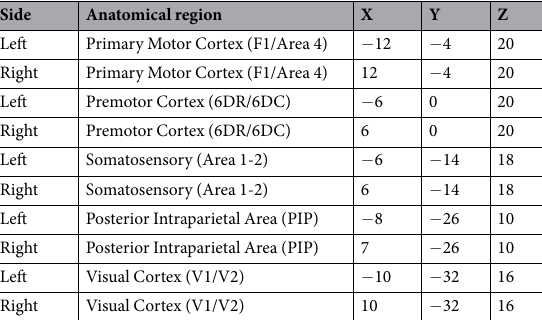
Finally, the third was also an increase in FC between the right visual and the left primary motor cortex (PMC). This FC had a significant negative correlation with the NHPSS scale (r = − 0.78, p = 0.004) (Fig. 3, third row). Discussion